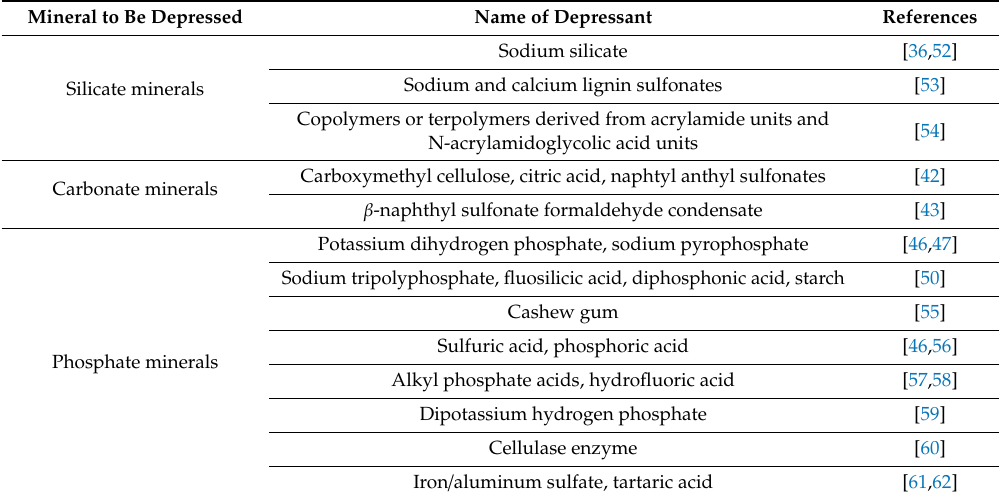
Table 2. Depressants used in the flotation of phosphate